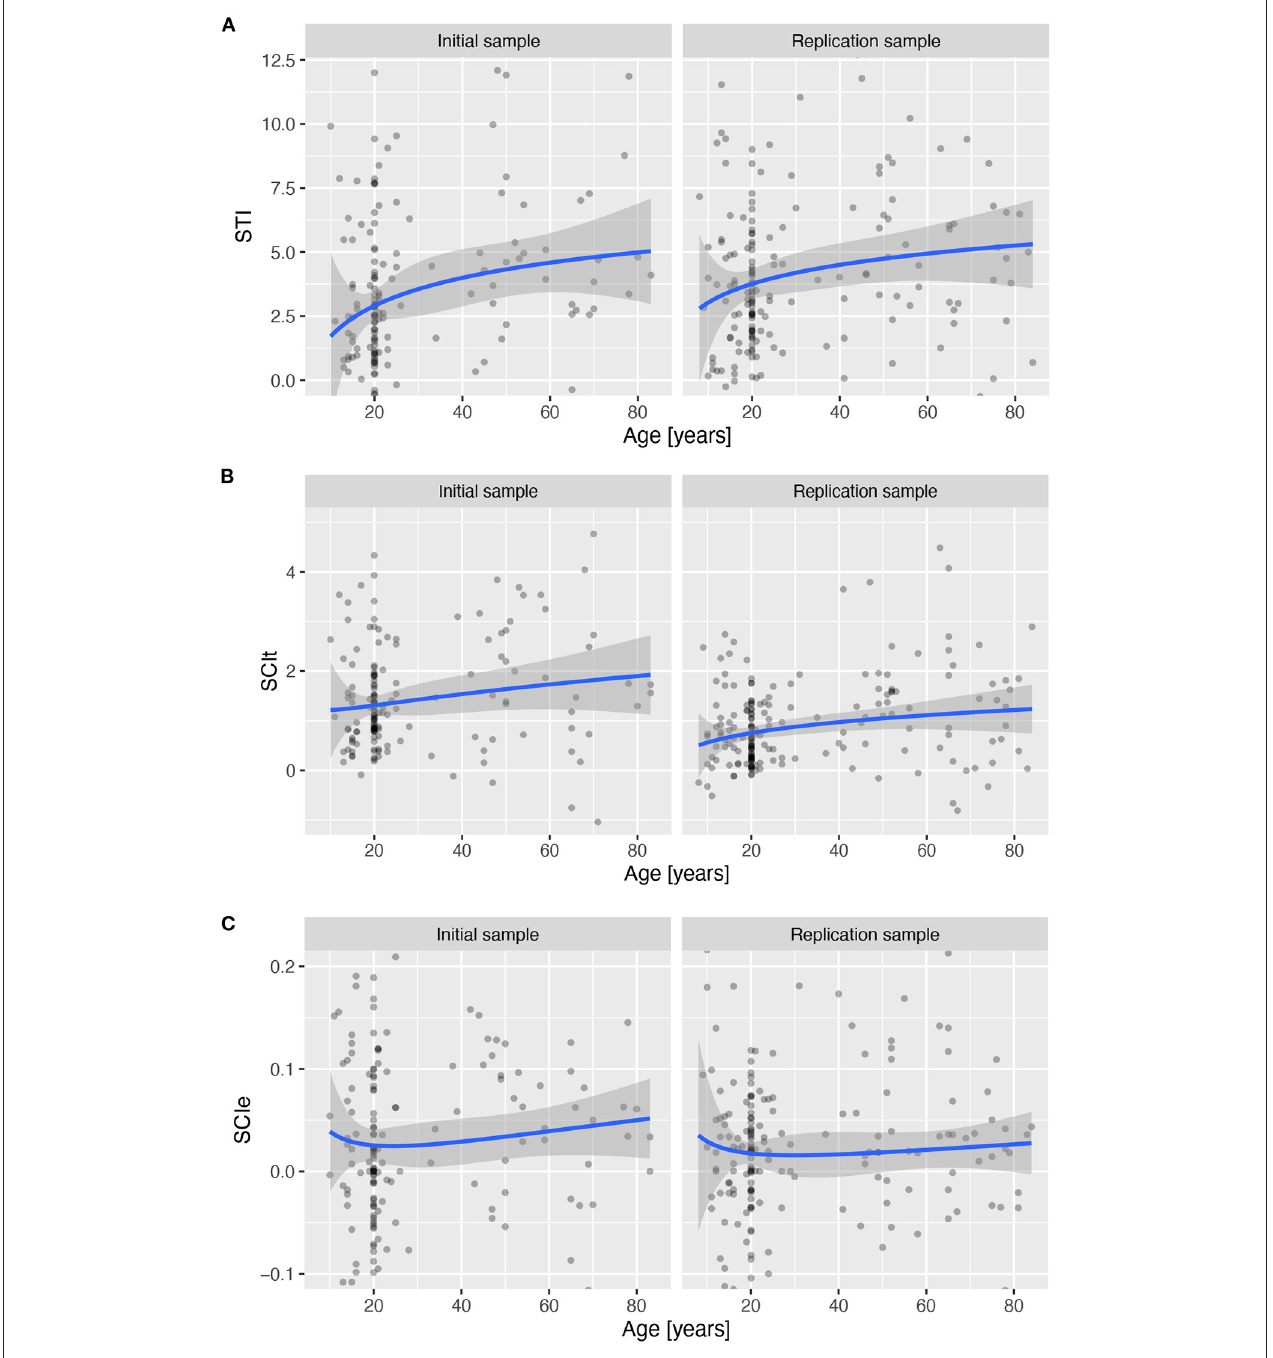
FIGURE 8 | Three derived measures across lifespan for the stable and flexible task mode over age for both samples. Lines show the predicted values based on a robust linear regression with age modelled as a second-degree polynomial of the log of age in years, and shading the standard error of the predicted values. (A) Setup Time Index ( SCI t ). (B) Error based Switching Cost Index ( SCI e ). (C) Preparation time based Switching Cost Index ( SCI t